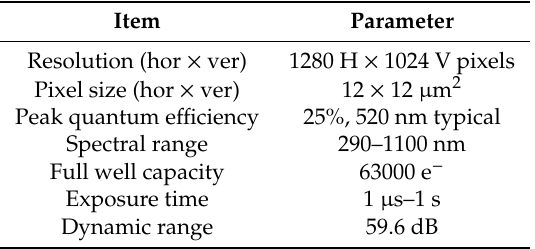
Figure 4. High-speed camera. Table 4. The main technical parameters of the high-speed camera.